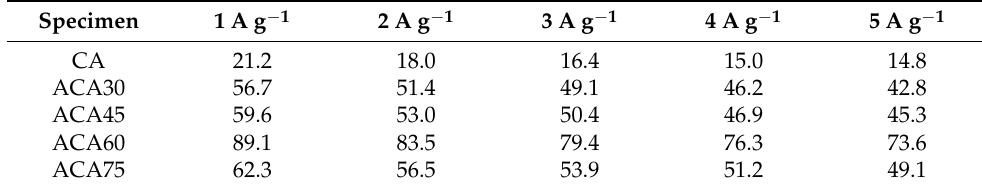
Table 2. Specific capacitances of samples (F g − 1 ). Table 3. Comparison of the specific capacitance with other literatures.